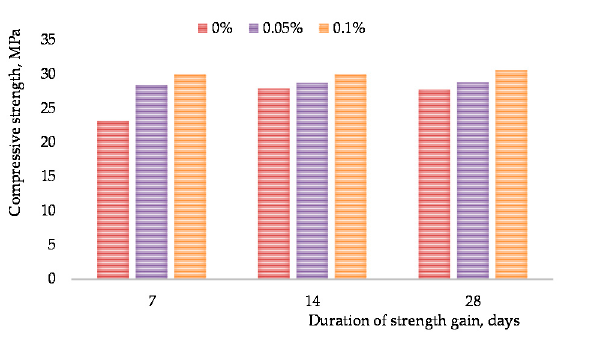
Figure 9. Influence of the CNPLUS and ViscoCrete 2100 content on the strength properties of concrete grout: ( a ) ultimate compressive strength; ( b ) ultimate tensile strength at bending.